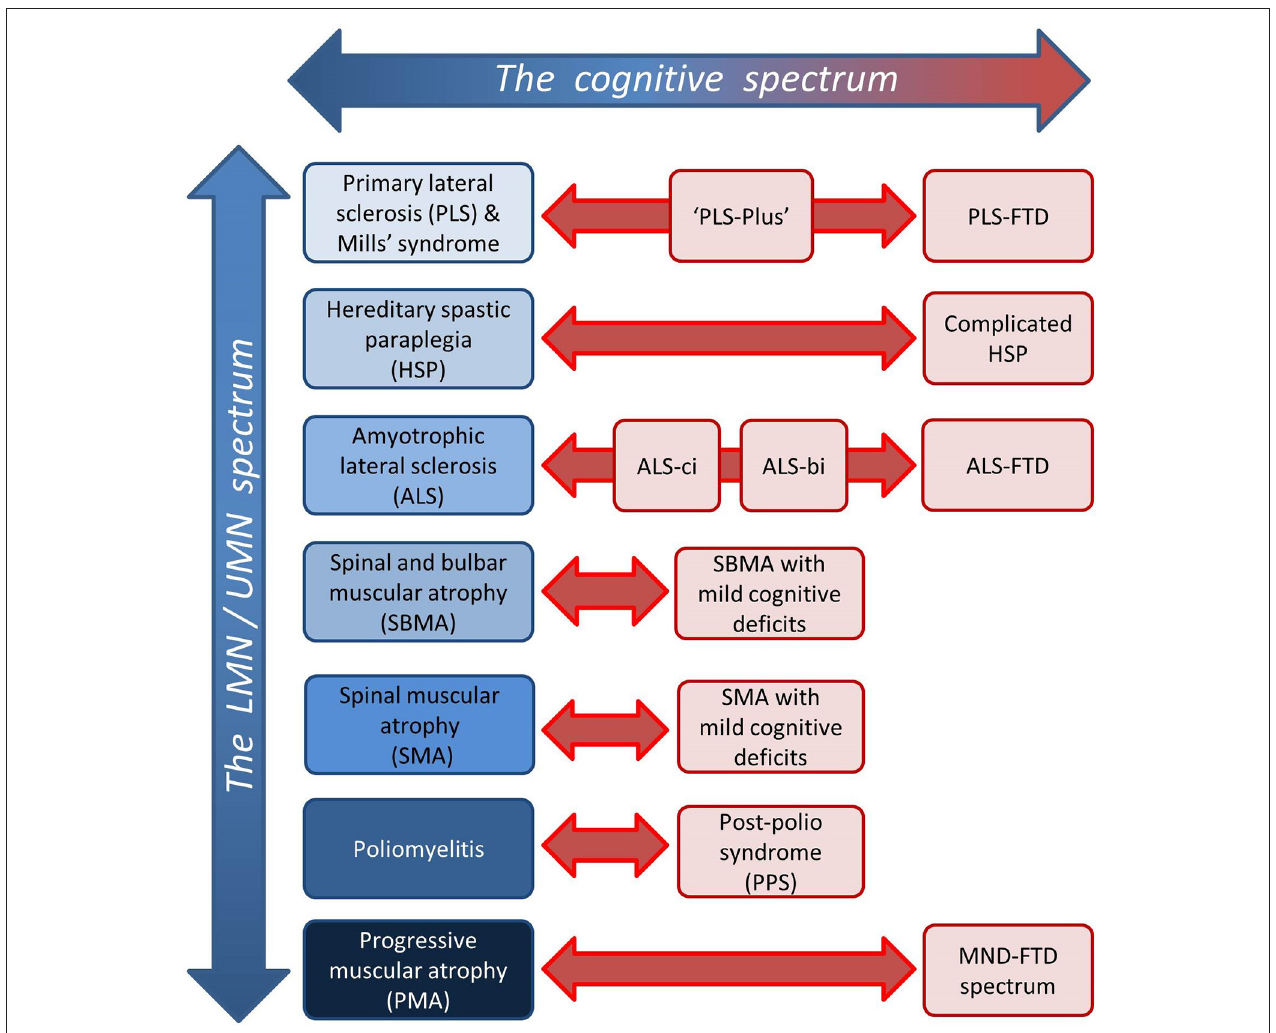
FIGURE 1 | Dimensions of disease heterogeneity in MND; the spectrum of relative upper/lower motor neuron involvement and the spectrum of extra-motor